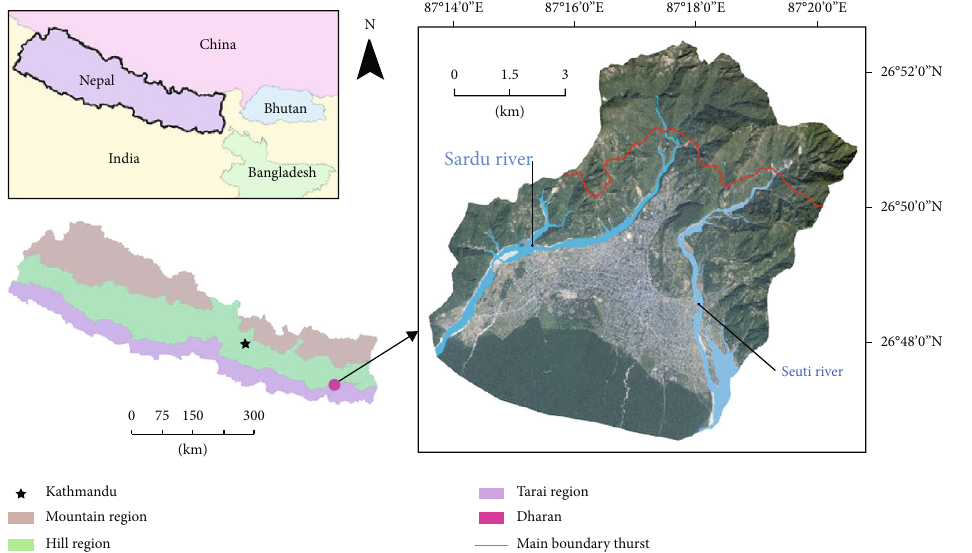
Figure 1: Map of Nepal representing the study site: Dharan Submetropolitan City (obtained from Dharan Submetropolitan City O ffi ce,